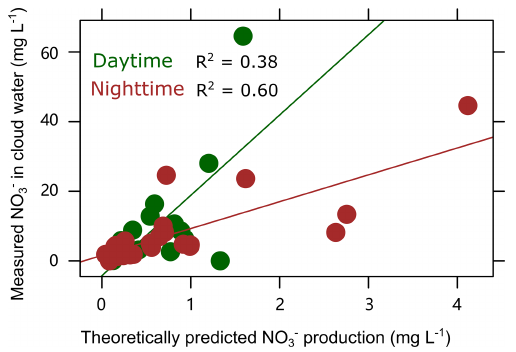
Figure 3. Theoretical calculation of the trend of in-cloud-produced nitrate from the hydrolysis of N 2 O 5 versus the temporal variations